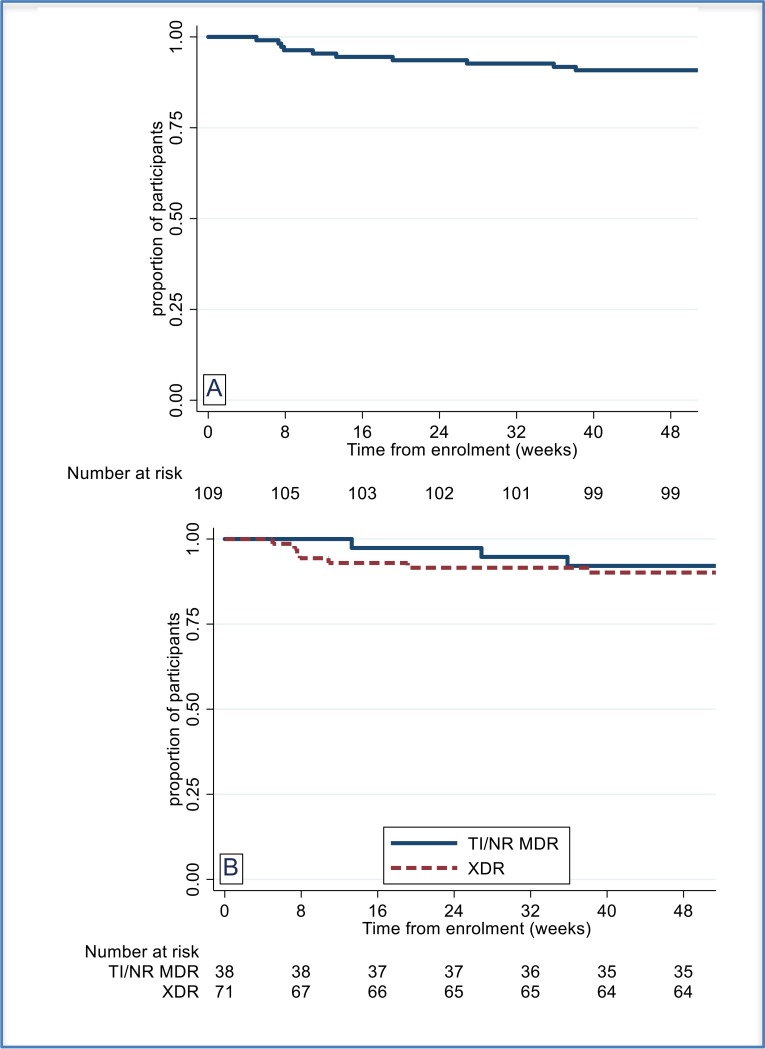
Time to unfavourable outcome (ITT)A Overall; B by TB Type